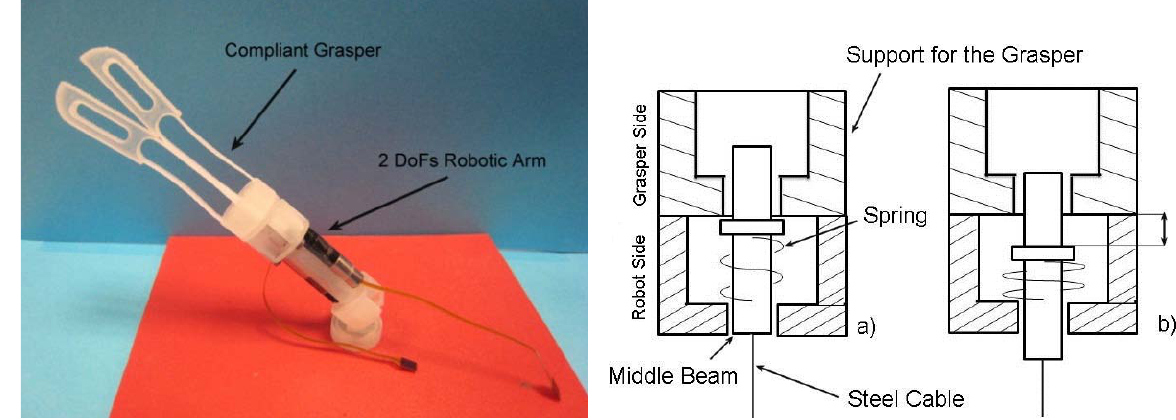
Figure 7. (a) Fabricated robot and grasper mock-up prototypes; (b) Mechanisms for coupling the grasper to the robotic arm, a) initial configuration; b) actuated